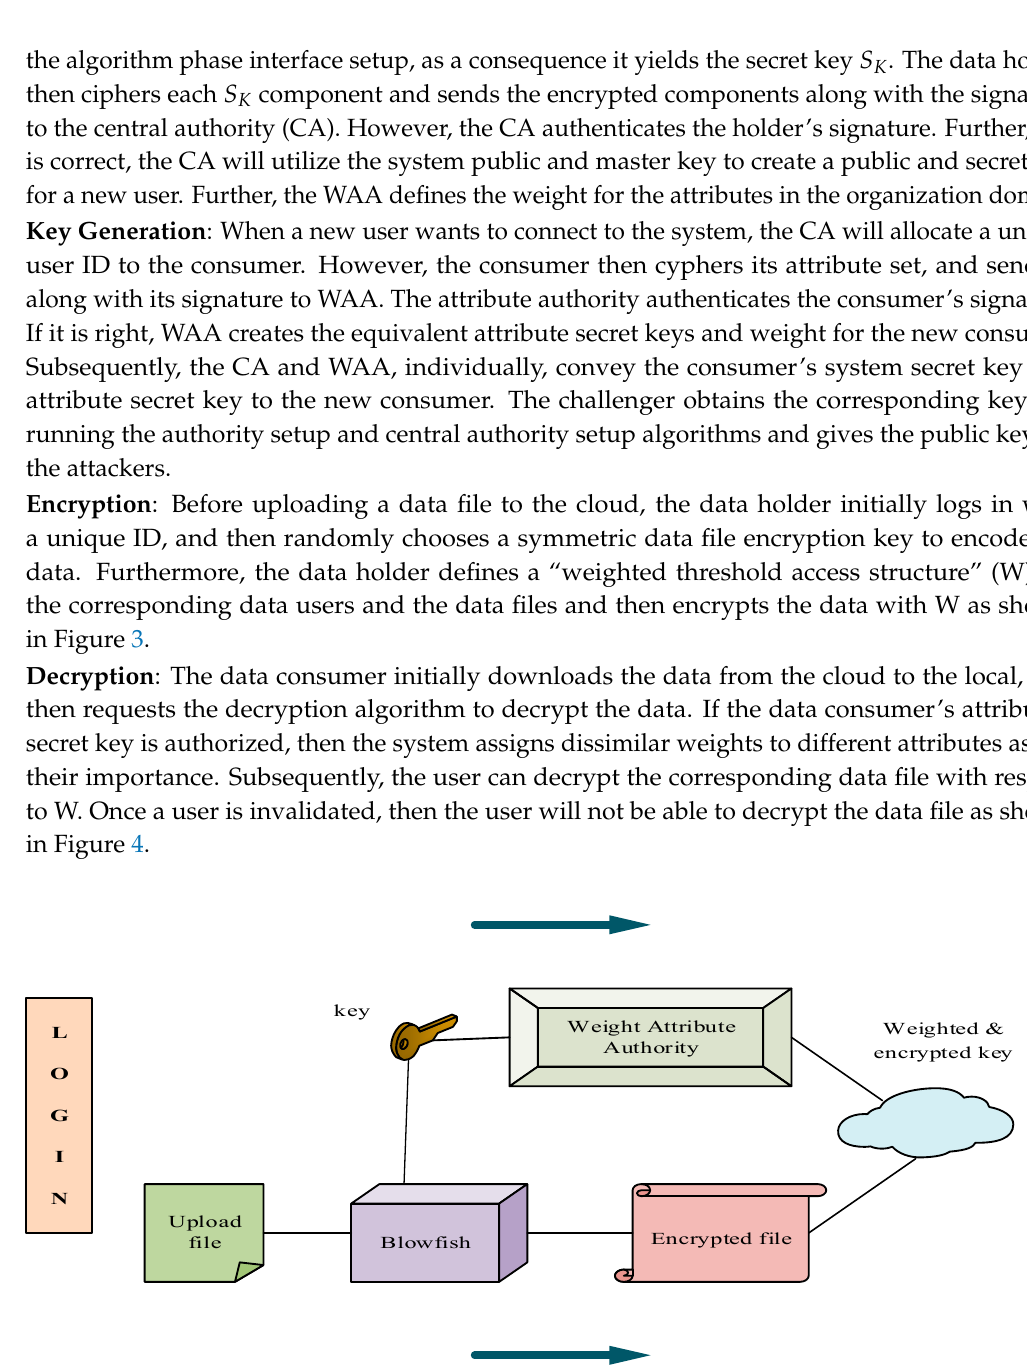
Figure 3. Data owner side (encryption process).